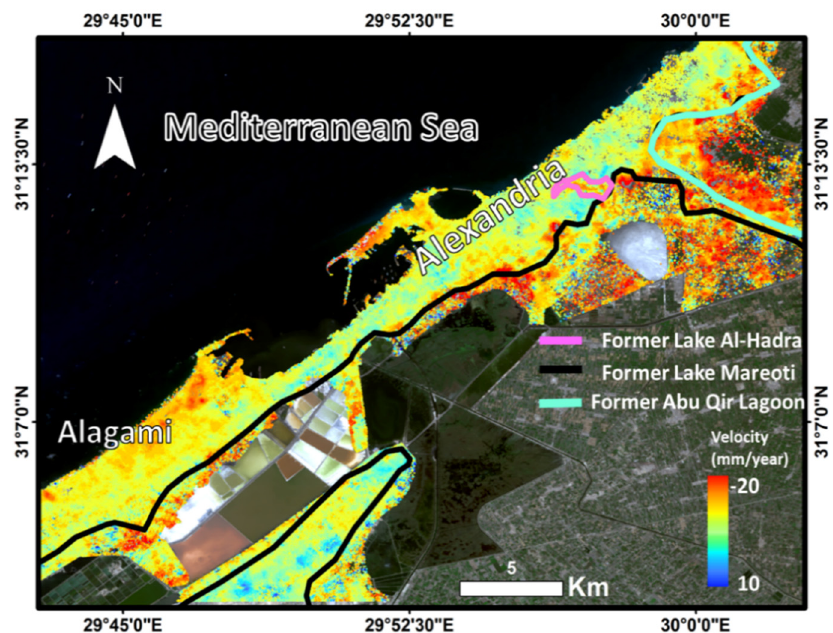
Figure 16. Former lakes and lagoons in Alexandria based on displacement velocity of Alexandria and Alagami cities using the Sentinel-1 data from August 2017 to September 2020. Different levels of subsidence at different locations along the study area leave visual marks on the surface of the city. The field investigation provided supporting evidence of the results presented in this study. Figure 17 shows the visual cracks on buildings and roads captured at subsided locations, as defined in our vertical displacement results. Different degrees of subsidence can be easily inferred from the road cracks shown in the pictures in Figure 17b–d. The subsidence and field-checked buildings were plotted on the final land subsidence maps derived from Sentinel-1 data using the SBAS technique. The location of the affected buildings shows high consistency with the estimated results of the DInSAR. The frequently occurred land subsidence events along the Alexandria City, especially along the newly urbanized areas should be carefully considered for future expansion or any other developmental plans. This is to avoid any related hazards that might cause damages. The western desert fringes of Alexandria should be considered for future developmental plans instead of the southern part of the city, which is suffering from the high subsidence rate due to its fragile substrate